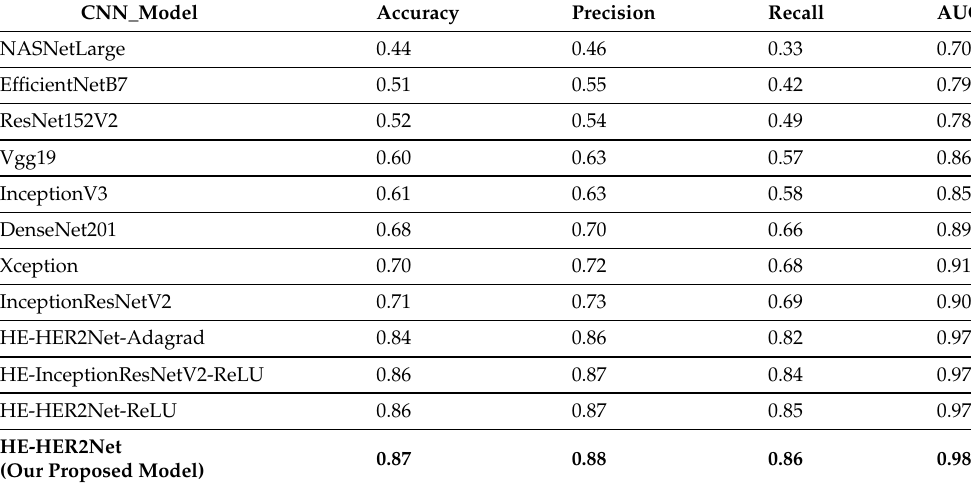
Table 3. This table illuminates the performance evaluation of all the models, such as accuracy (ACC), precision (P), recall (R), and AUC. The bold sentence in the below column of the table represents the proposed